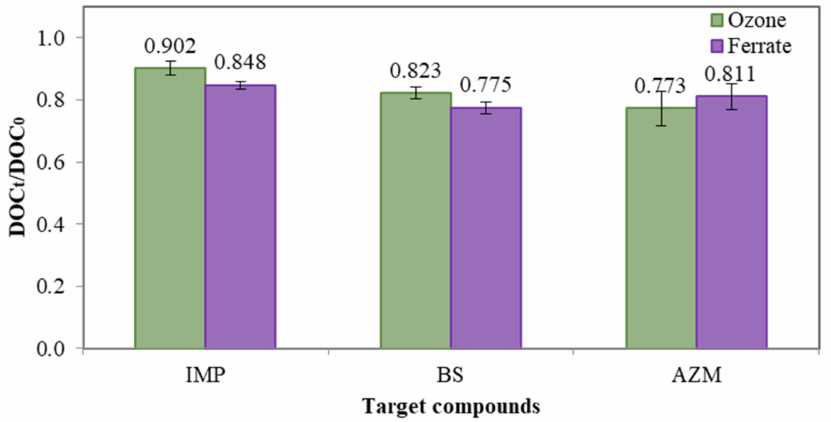
Figure 4. Mean DOC reduction of IMP, BS and AZM with ferrate(VI) and ozonation, respectively. The dosage of ferrate(VI) and ozone was 0.036 mM. Test solution. concentration = 1000 µ g L − 1 and pH = 7.